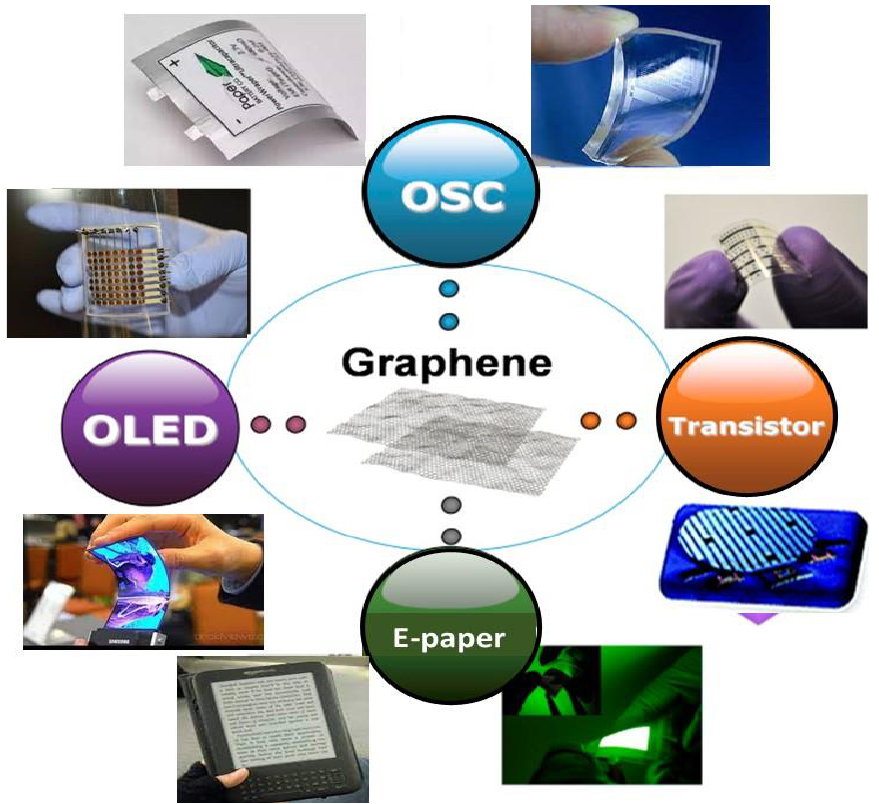
Figure 1. Representation of the applications of graphene in flexible electronics.